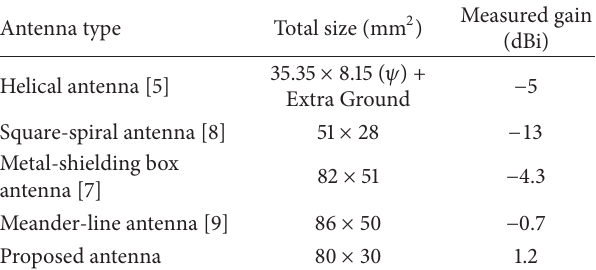
Table 1: Comparison of various